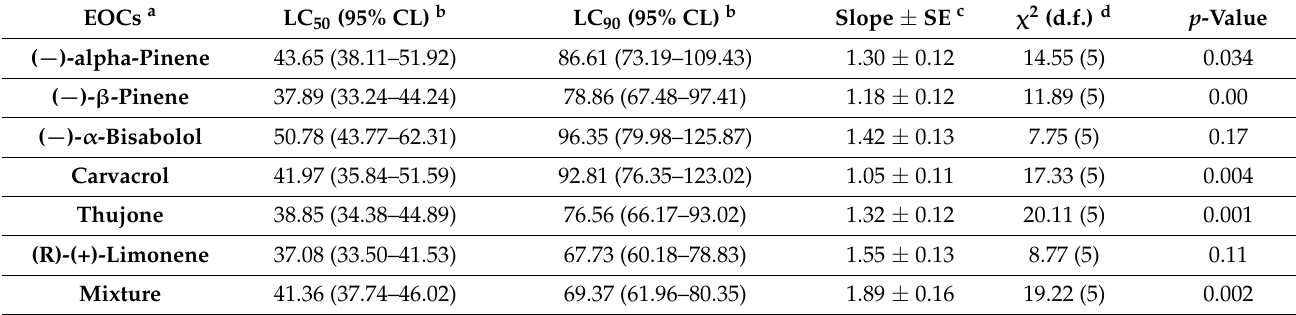
Table 3. Toxicity of different EOCs in ingestion toxicity bioassay against B. dorsalis adults.